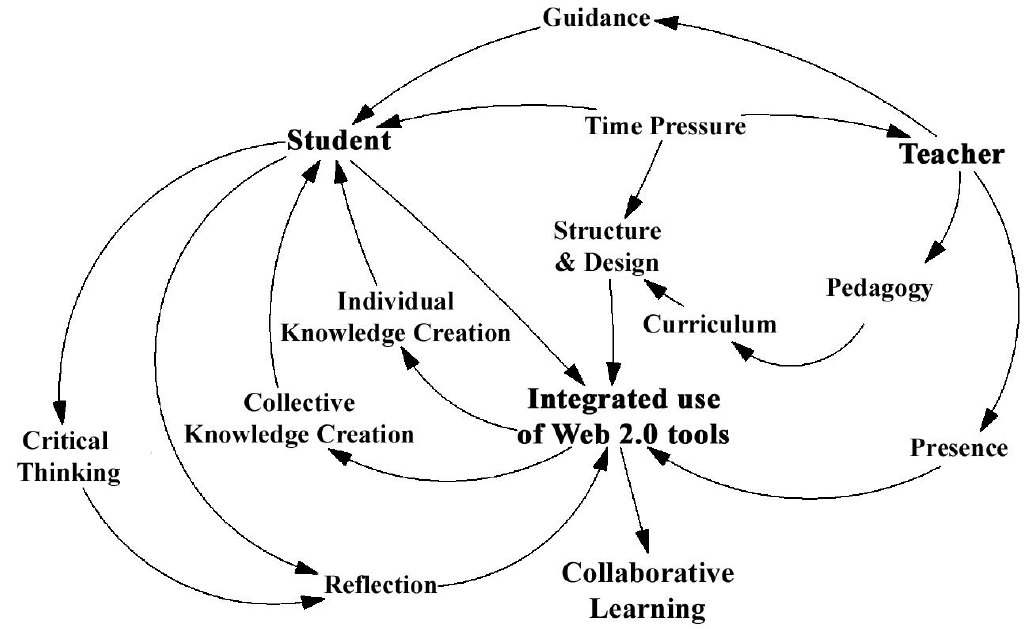
Figure 1. Conceptual model of a Web 2.0 community of inquiry, illustrating relationships between teacher, student and the integrated use of Web 2.0 tools.